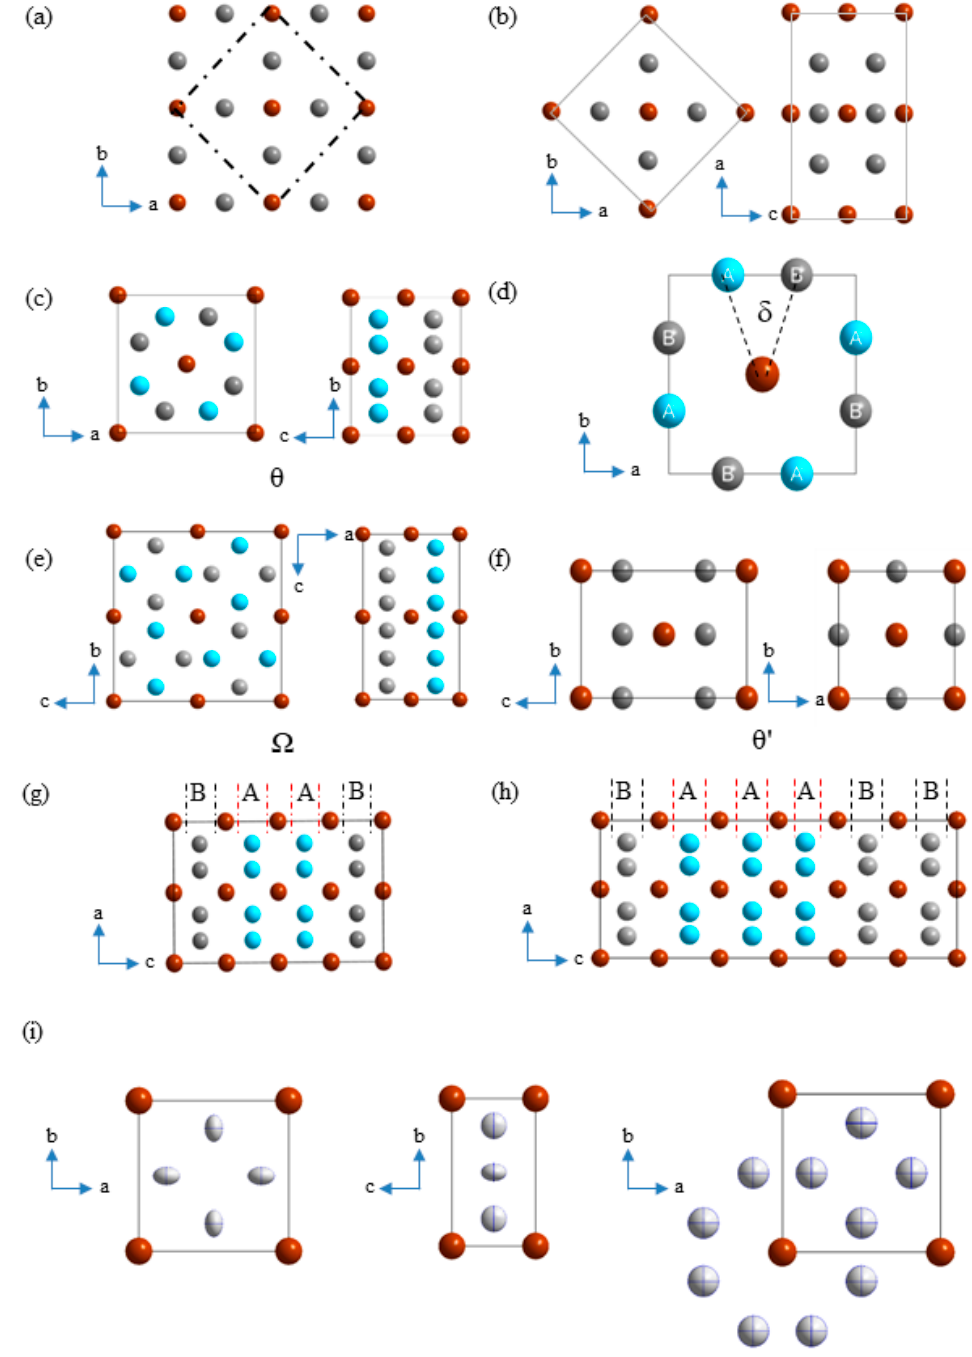
Figure 3. Crystal structure of the existing and potential Al 2 Cu phases. ( a ) The 2 × 2 × 2 supercell of Owen-Al 2 Cu; ( b ) a different description of the Owen phase as indicated by the black dotted lines in ( a ); ( c ) the θ phase; ( d ) the A and B layers each formed by four Al atoms in the unit cell, as shown along the c axis; ( e ) the Ω phase; ( f ) the θ ’ phase; ( g ) the M1 phase; ( h ) the M2 phase; and ( i ) the pseudo phase. (The Cu atoms are indicated in brown color balls in all cases, and the rest balls represent the Al atoms. The A and B layer discussed in the text are represented by sky-blue and gray Al atoms, respectively).